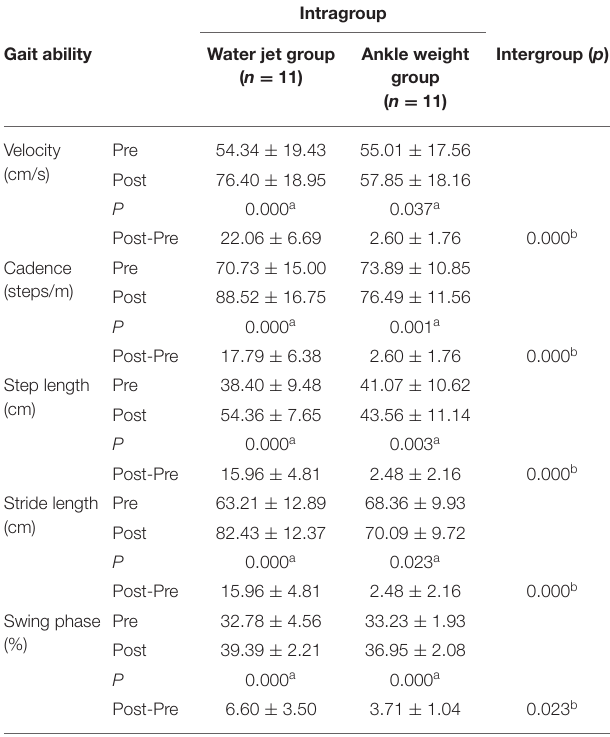
TABLE 3 | Changes in gait ability within each group and between the two